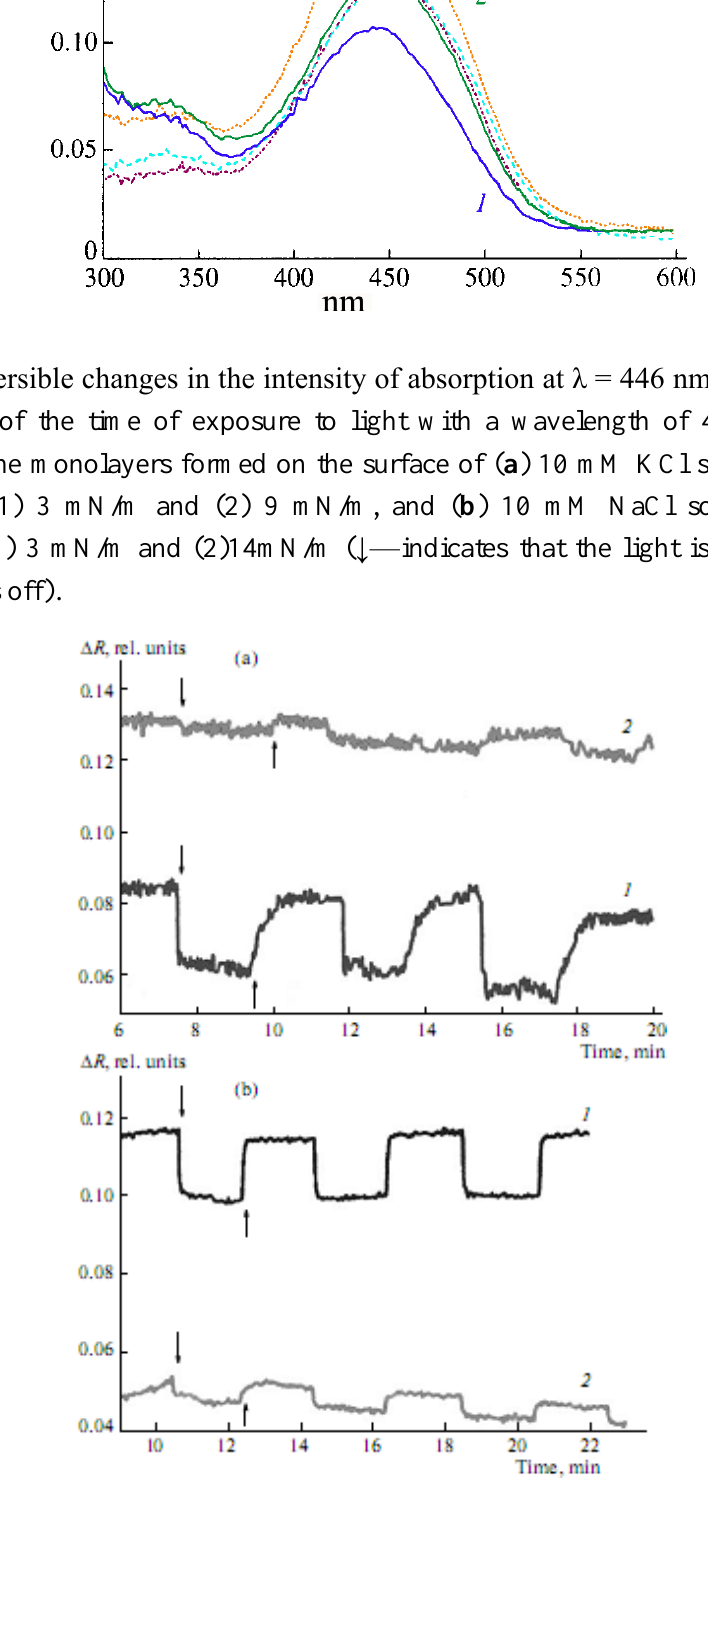
Figure 4. Absorption spectra of type-Ib CCDs in monolayers on the surface of: (1) distilled water and 10 mM solutions of (2) KCl, (3) CaCl